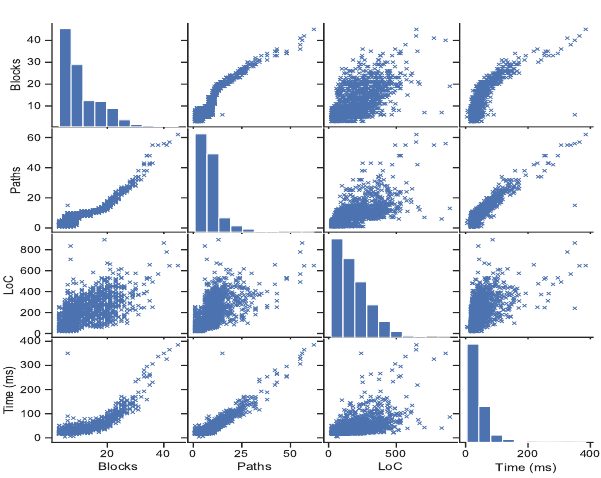
Figure 4. Pairwise plot for the experiment data